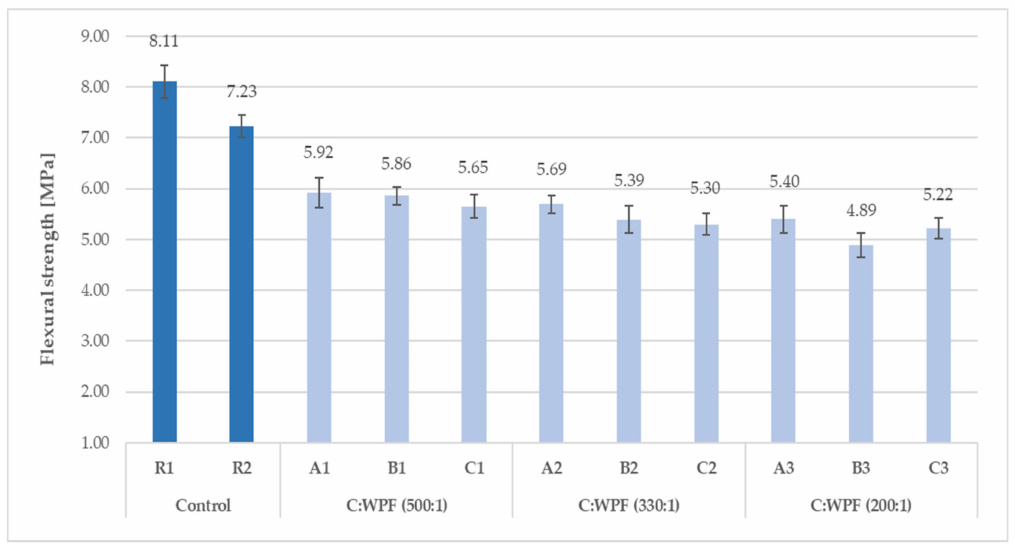
Figure 17. Flexural strength of fiber-cement mortars with different C/WPF ratios (set I).